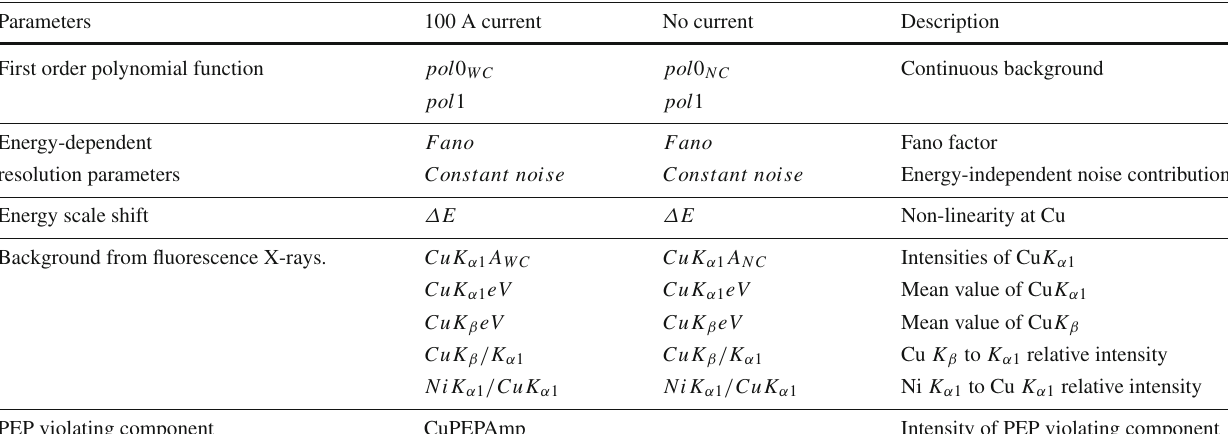
Fig. 8 A global chi-square function was used to fit simultaneously the spectra with and without 100 A current applied to the copper conduc- tor. The energy position for the expected PEP violating events is about 300 eV below the normal copper K α 1 transition. The Gaussian function and the tail part of the K α 1 components and the continuous background Table 1 Free parameters for the simultaneous fit function. Common parameters are placed in the center of the two middle columns Parameters